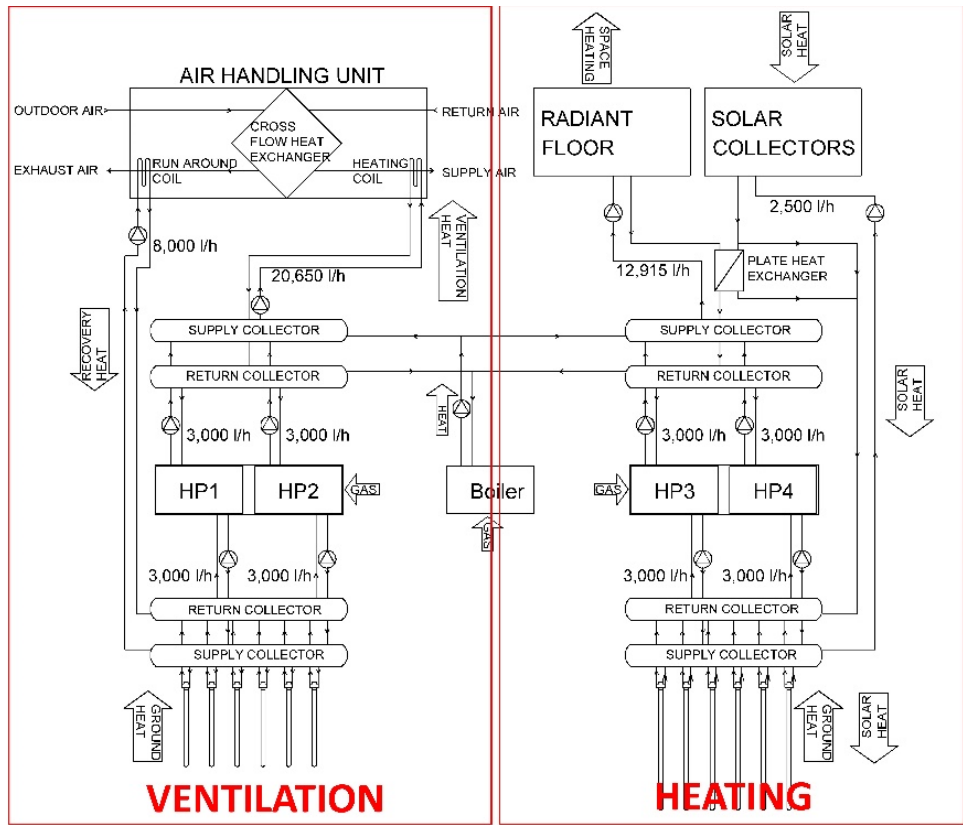
Figure 2. Reduced functional diagram of the HVAC plant. The main mass and energy flows (gas, ground, solar, and recovery) are shown.